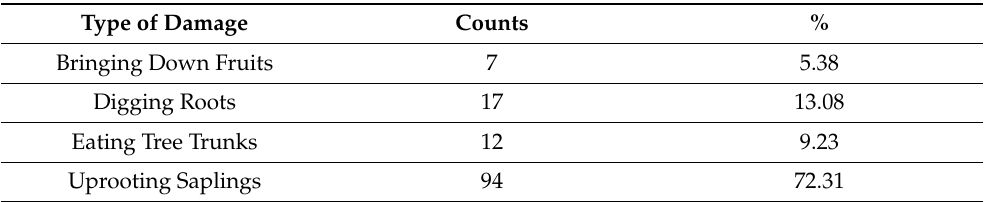
Figure 2. The bi-plot indicating the importance of the crop damage-related factors. The orange color intensity represents the importance of each factor. The first component explains 40.6% of the variations in the total data, while the second component explains 22.7% of the total variations. Table 5. Orchard damage type ( n = 130) by wild boars used in the orchard damage-based PCA. The values shown include the number of crop damages for each level (counts) and the percentages (%) for each categorical factor used in the orchard damage-based